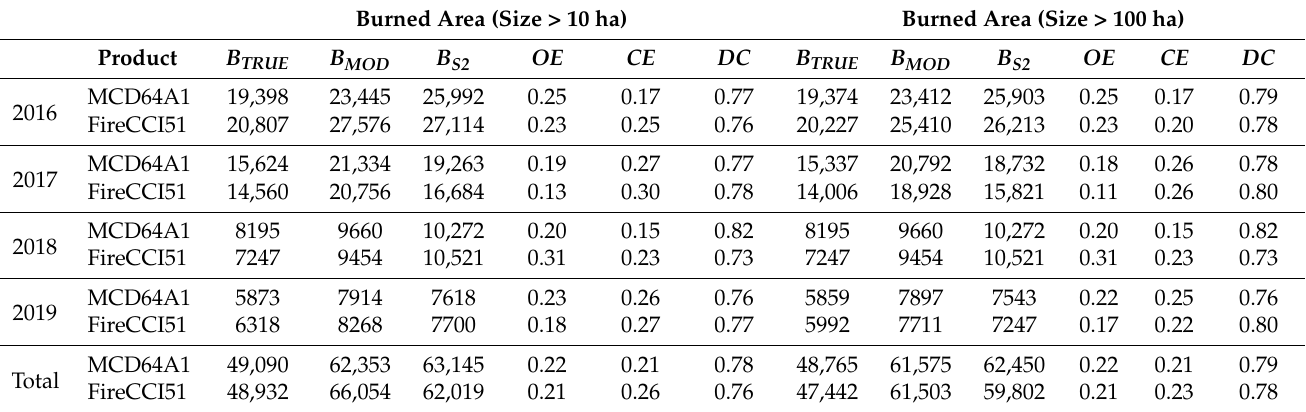
Table 2. Confusion matrix and accuracy metrics for the burned area mapped by the MODIS BA products in Greece (2016–2019), considering the spatially coincident fires with Sentinel-2 reference data. The same metrics as in Table 1 are estimated, for two size groups. B TRUE is the common area mapped by MODIS and Sentinel-2, B MOD is the area mapped by MODIS only and B S2 is the actual area mapped by